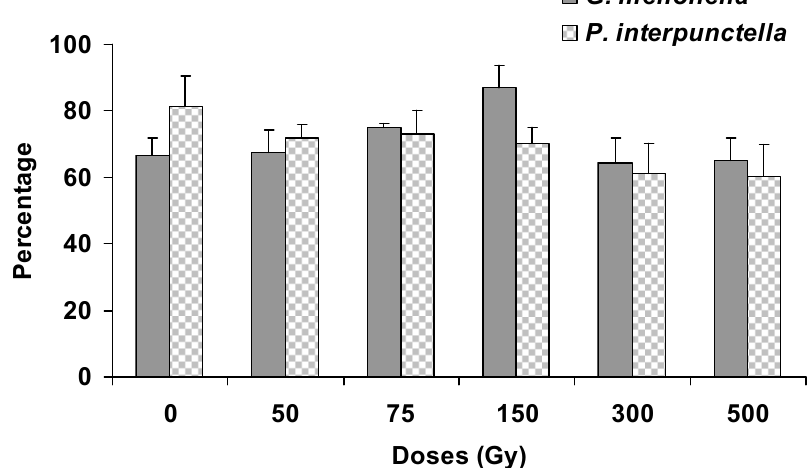
Figure 3. Percentage of adult emergence (% ± SE) of parasitoid H. hebetor developing from the irradiated larvae of G. mellonella and P. interpunctella.